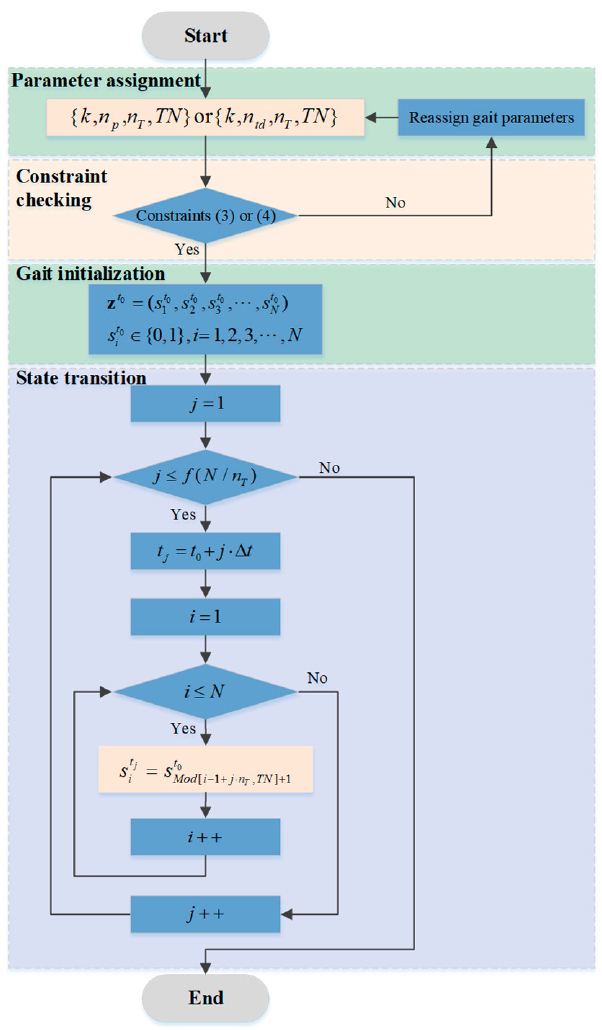
Figure 7. Routine of the generation algorithm for MG- Ⅱ .